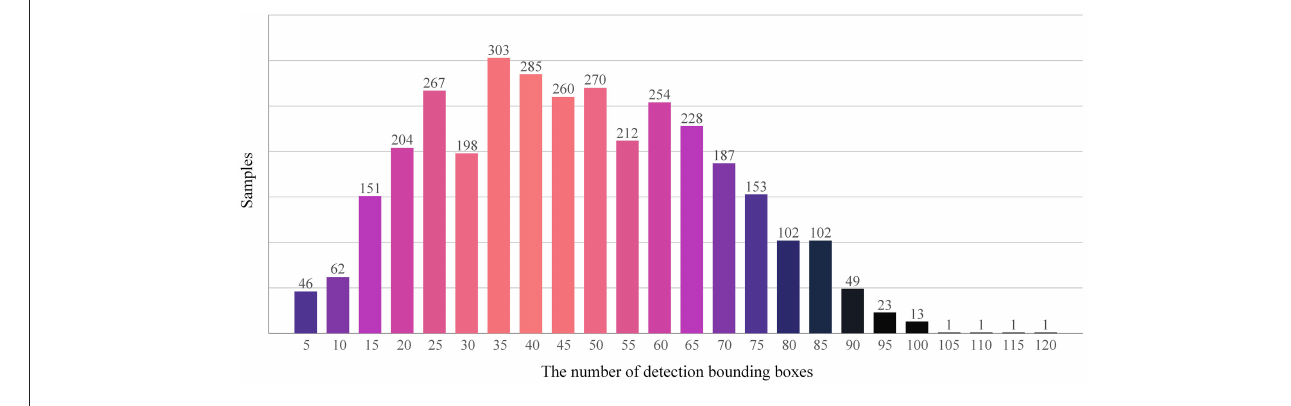
FIGURE 2 | Histogram of the detection boxes in the data set.